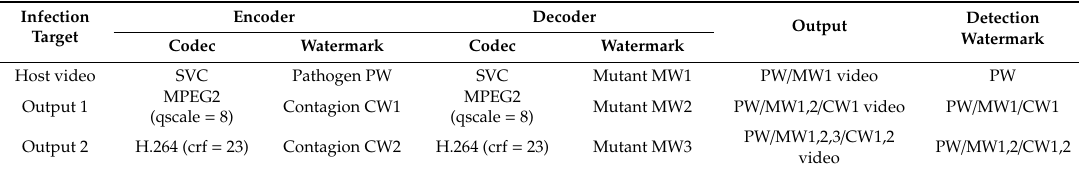
Table 1. Infectious simulation scenario 1 using MPEG-2 and H.264 / MPEG-4 AVC for low resolution (64-bit watermark).